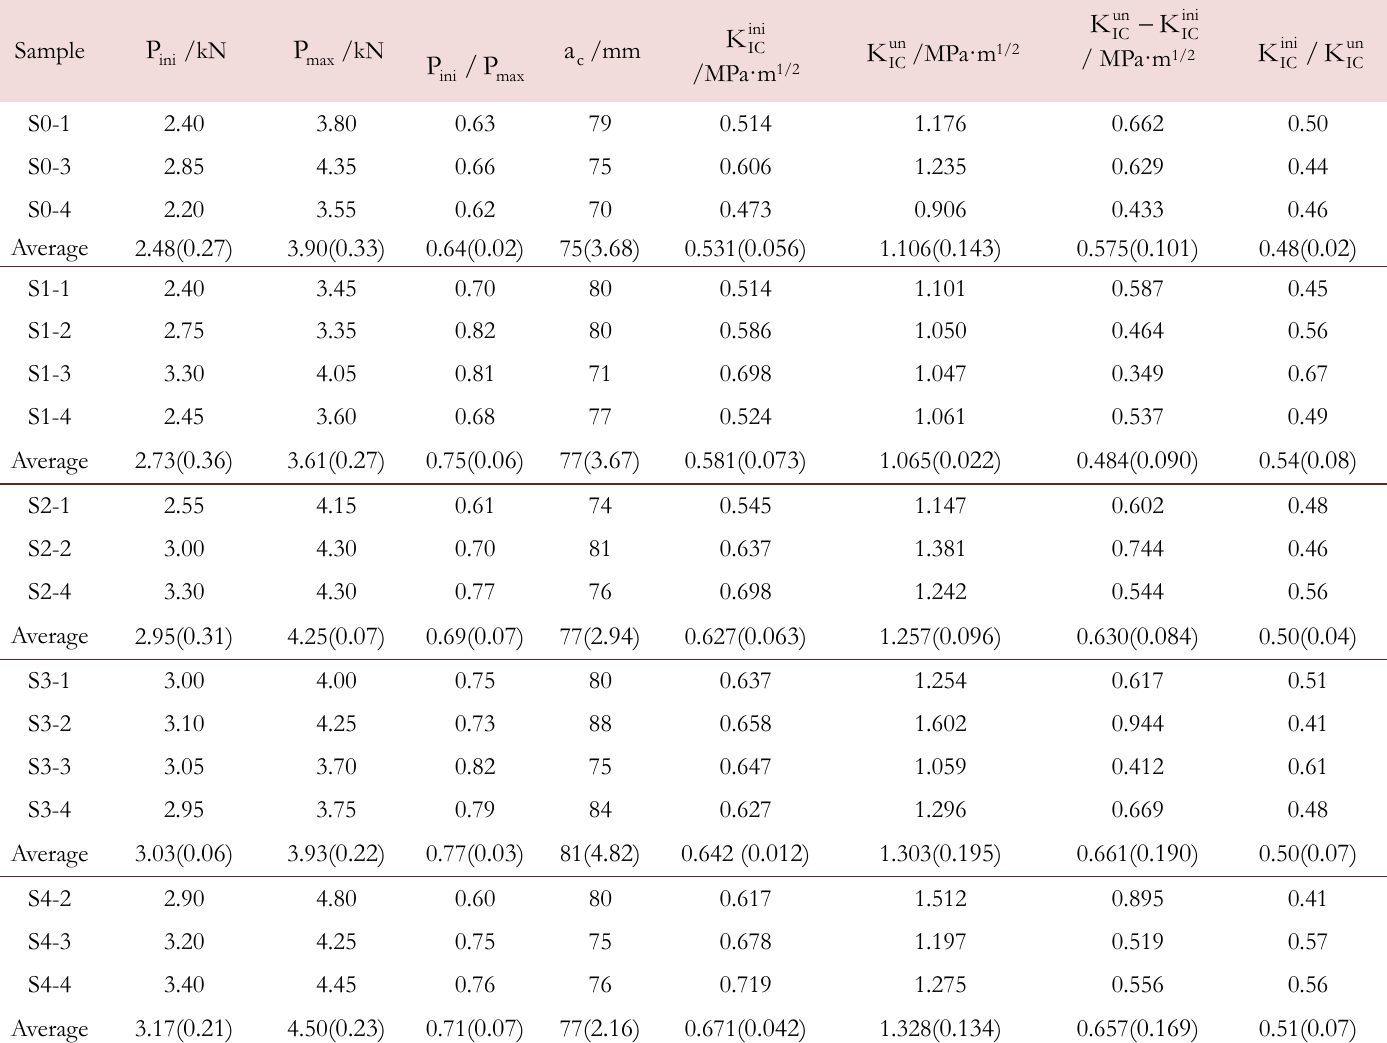
Table 3: Double-K fracture parameters of specime ns (standard deviations in